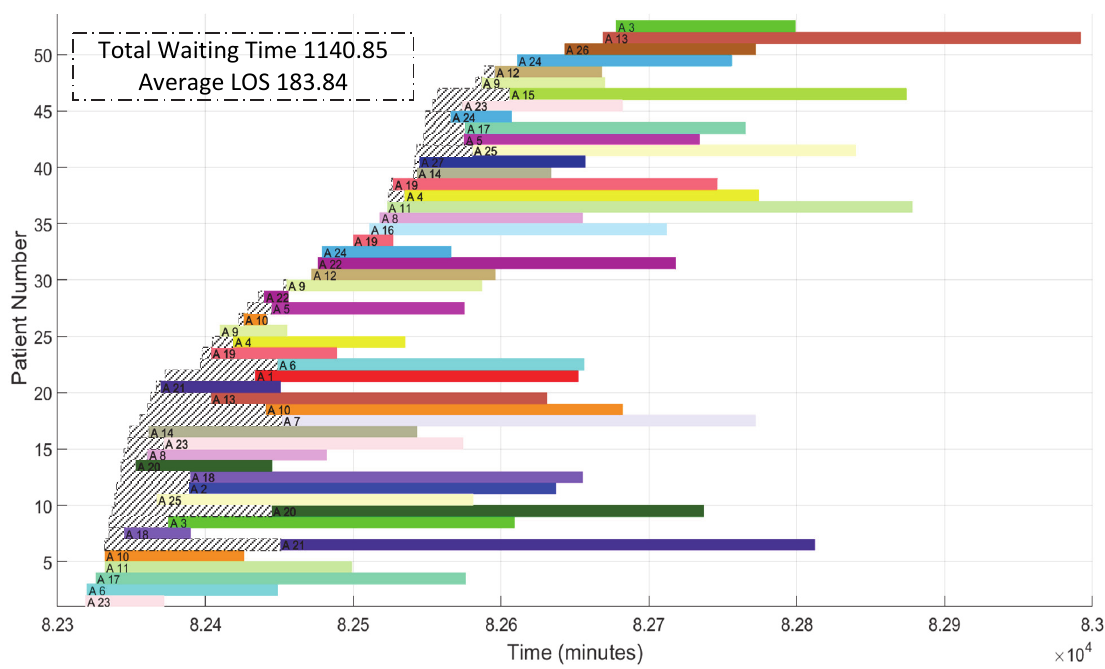
Fig. 10(b). Patient scheduling using BPF Fig. 10. Patient waiting time and bed blocking time using FCFS and